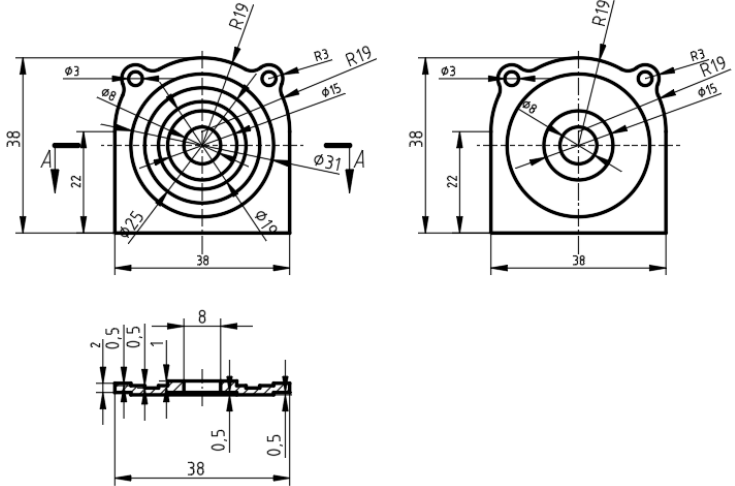
Figure 1. Two-dimensional drawings of PEI composite substrate. Table 1. Process conditions of surface neutralizing (Modifier A/B/C were purchased from MacDer- mid Co., Shanghai, China).